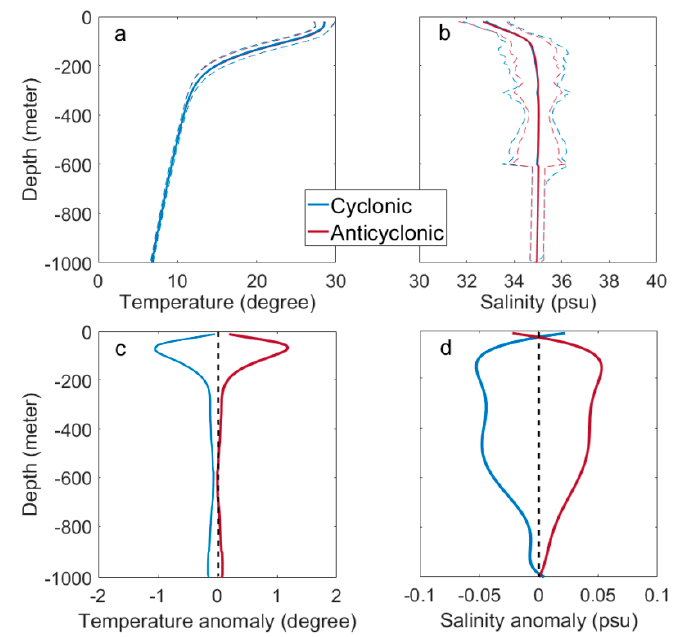
Figure 15. Mean temperature/salinity (T/S) vertical profiles (solid lines) from the Array for Real-Time Geostrophic Oceanography (Argo) data collected within the detected eddies in the study area. Mean ( a ) T and ( b ) S. Anomalies of ( c ) T and ( d ) S are also provided. Red lines are averages for profiles within AEs; blue lines are averages for profiles within CEs. (Dashed lines indicate the one standard deviation interval.).